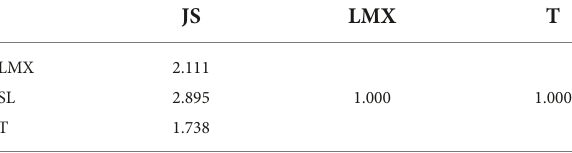
TABLE 6 Collinearity statistics: variance inflation